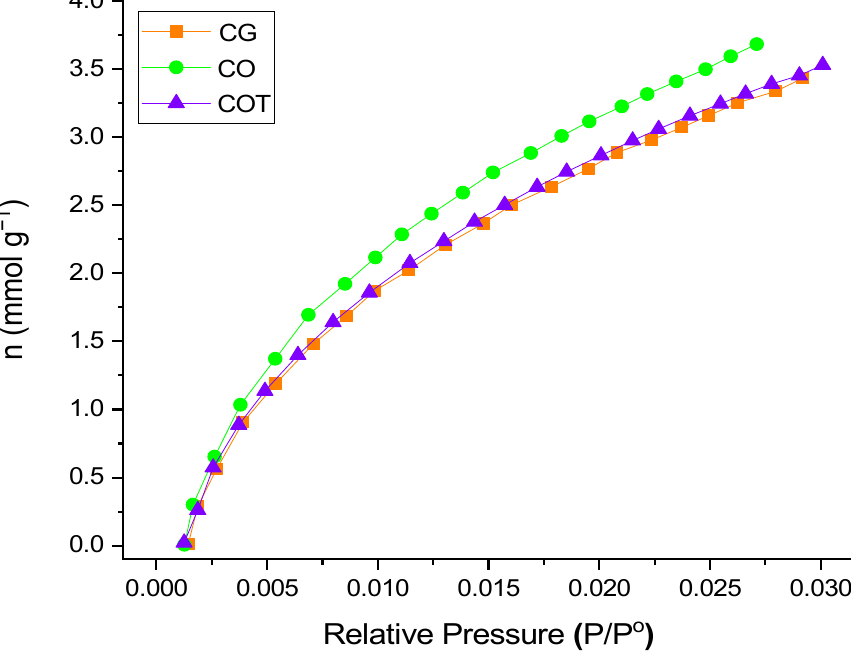
Figure 4. CO 2 adsorption isotherms at 273 K of activated carbons.